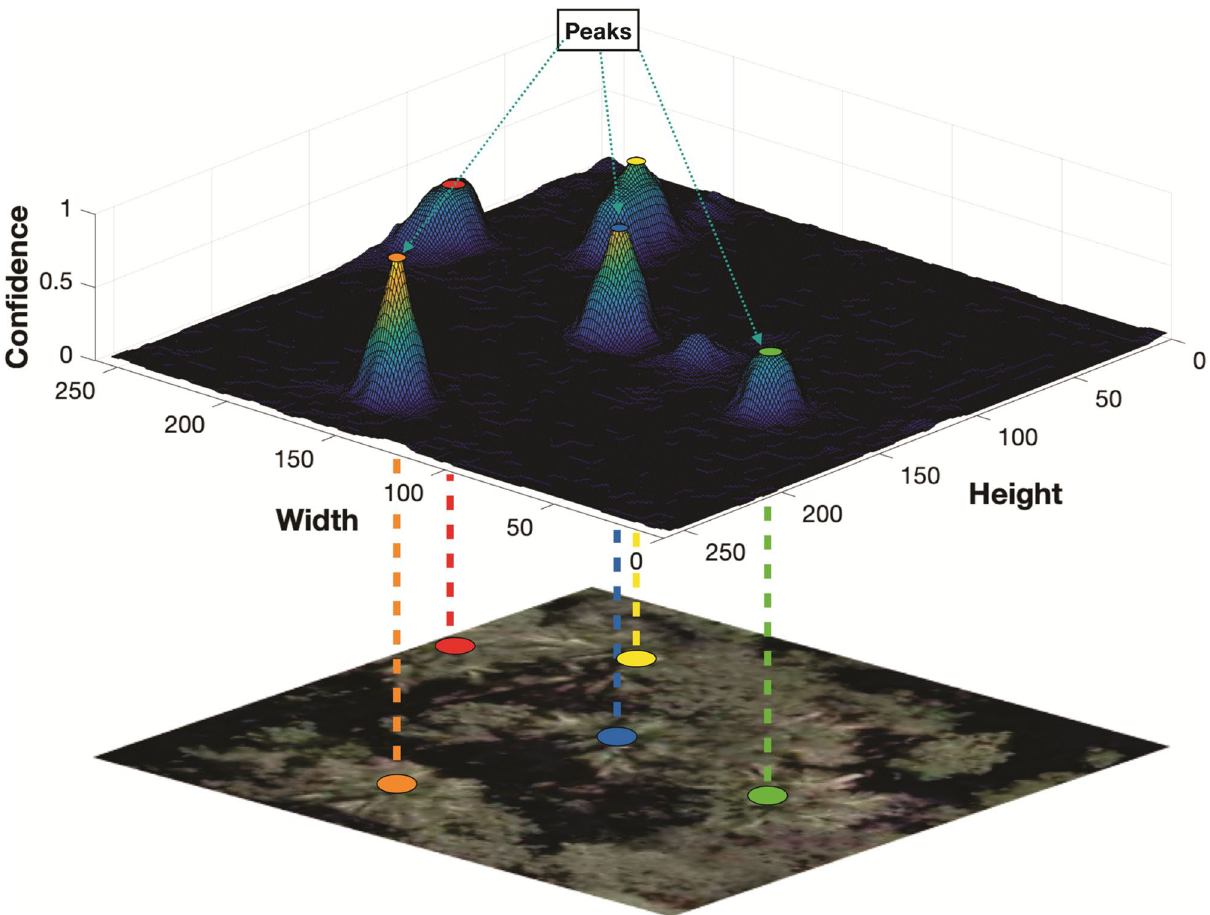
Figure 8. Tree localization example from a refined confidence map. Figure was created with Matplotlib 3.4.2: https:// matpl otlib.